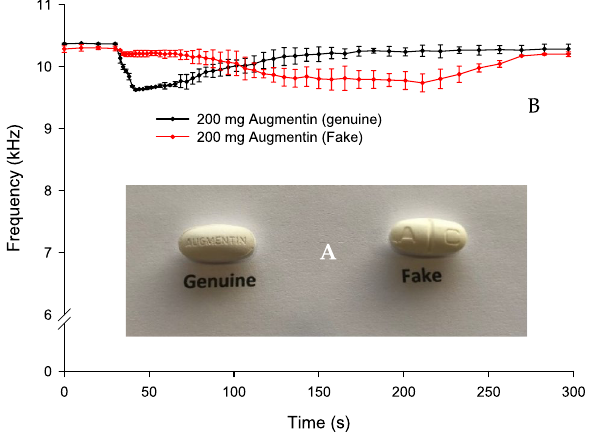
Figure 3. ( A ) An image of genuine and falsified amoxicillin-clavulanic acid tablets. ( B ) BARDS profile of 625 mg of genuine and falsified amoxicillin-clavulanic acid powder dissolved in 25 ml of deionised water.